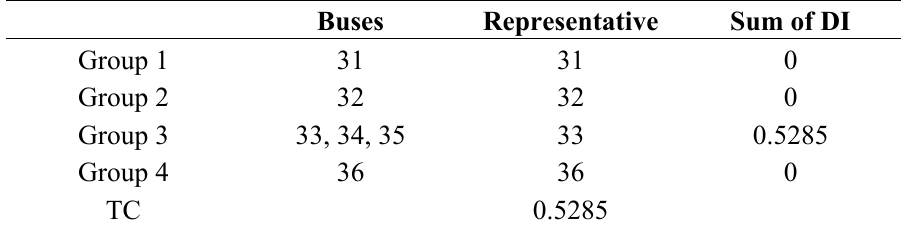
Table 3. Coherency identification result of k-mean